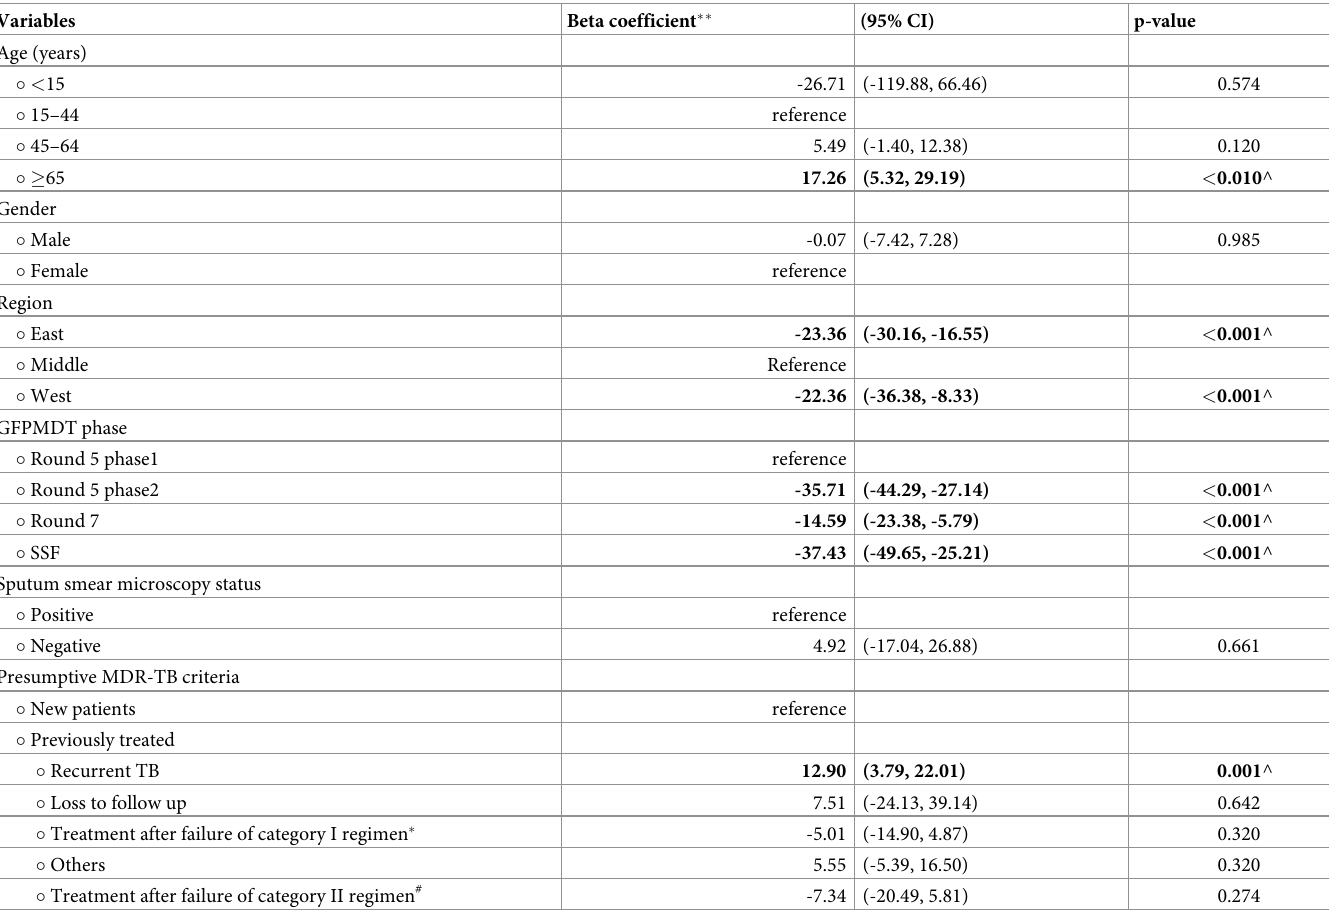
Table 6. Multivariable linear regression for factors associated with treatment initiation delay (between DST and treatment initiation) among bacteriologically-con- firmed MDR-TB patients registered for treatment under GFPMDT project in China, October 2006-June 2013 [N =